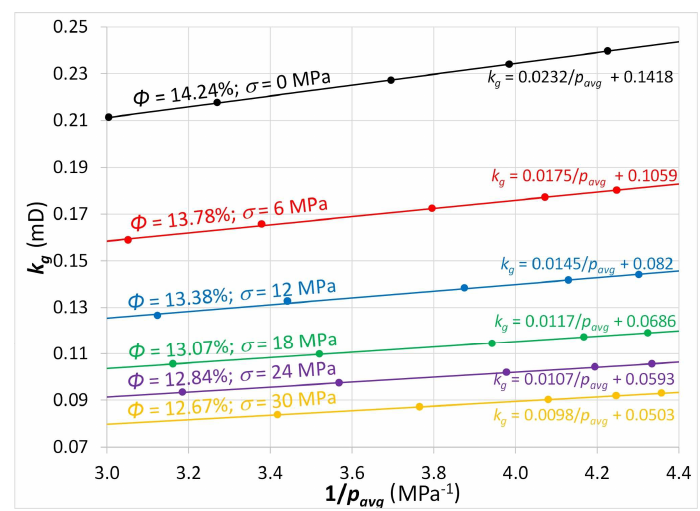
Figure 6. The relationship between the permeability coefficients k g of the sample N3 and nitrogen, as a function of the reverse nitrogen average pressure p avg , for various stress σ values and the corresponding sample porosities φ .